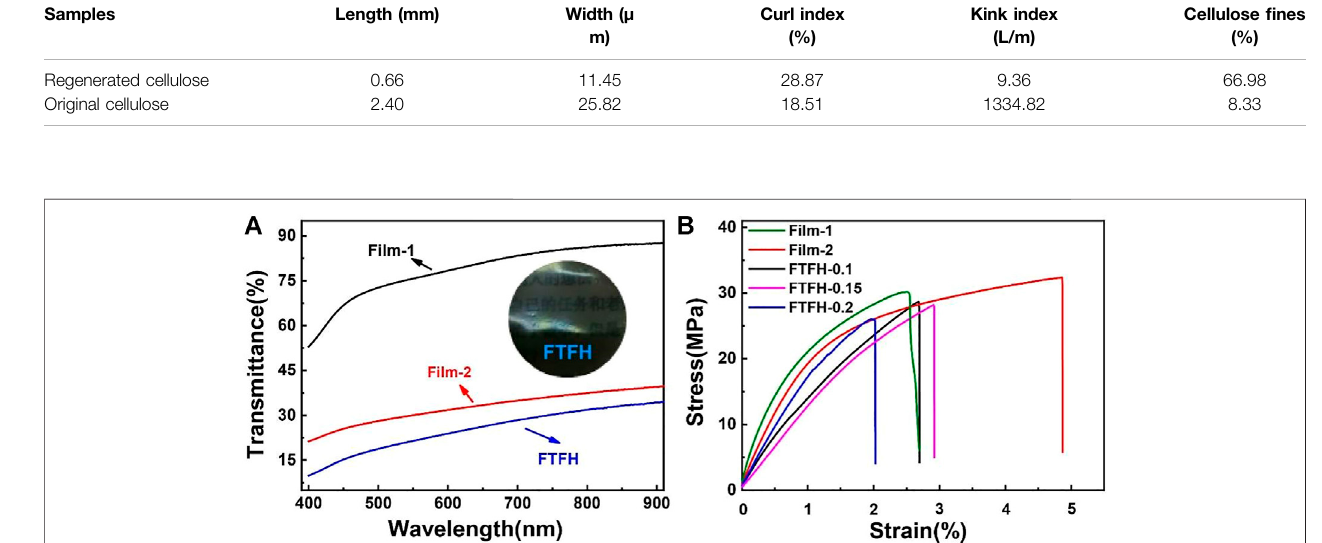
FIGURE 3 | (A) Optical transmittance plot for all Film-1, Film-2 and FTCT-0.15 in the range from 400 – 900 nm (B) Stress-strain curves of the Film-1, Film-2, FTFH- 0.1, FTFH-0.15 and FTFH-0.2.